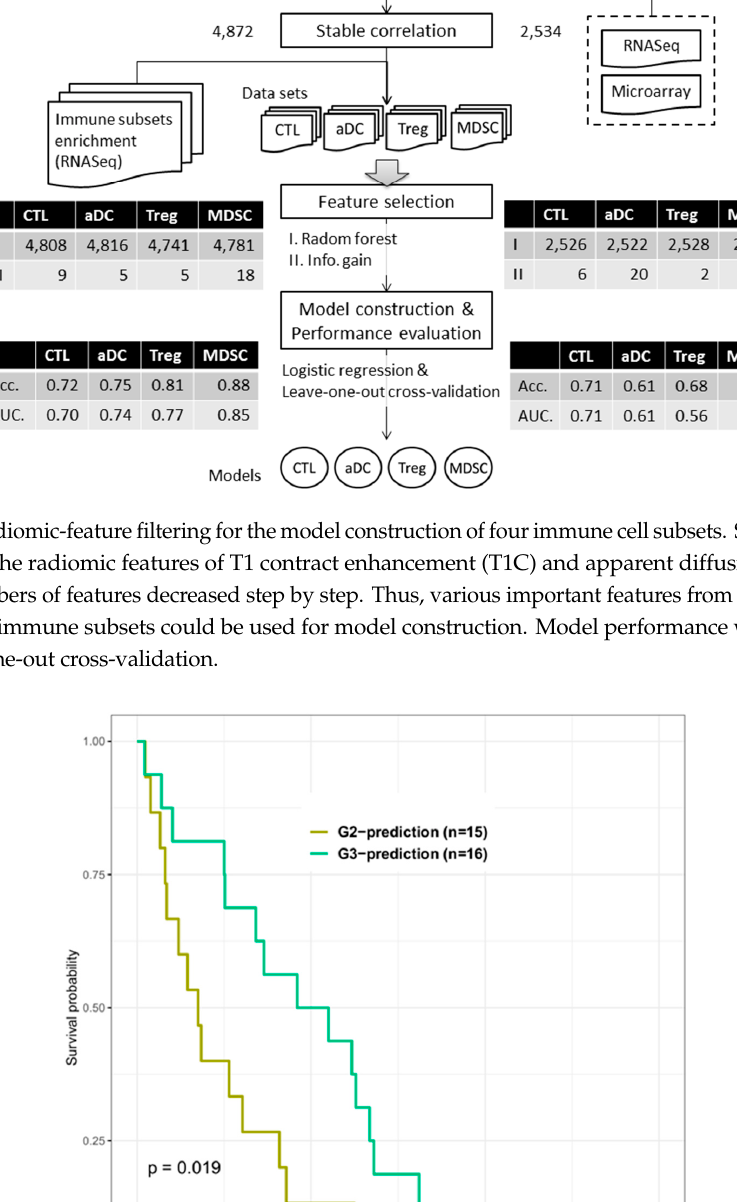
Figure 5. Enrichment levels of immune cell subsets between G2- and G3-prediction groups with microarray data. G2- and G3-prediction groups were determined using independent testing data ( n = 84) fed to the T1C radiomics models. X-axis indicates groups with different immune phenotypes,